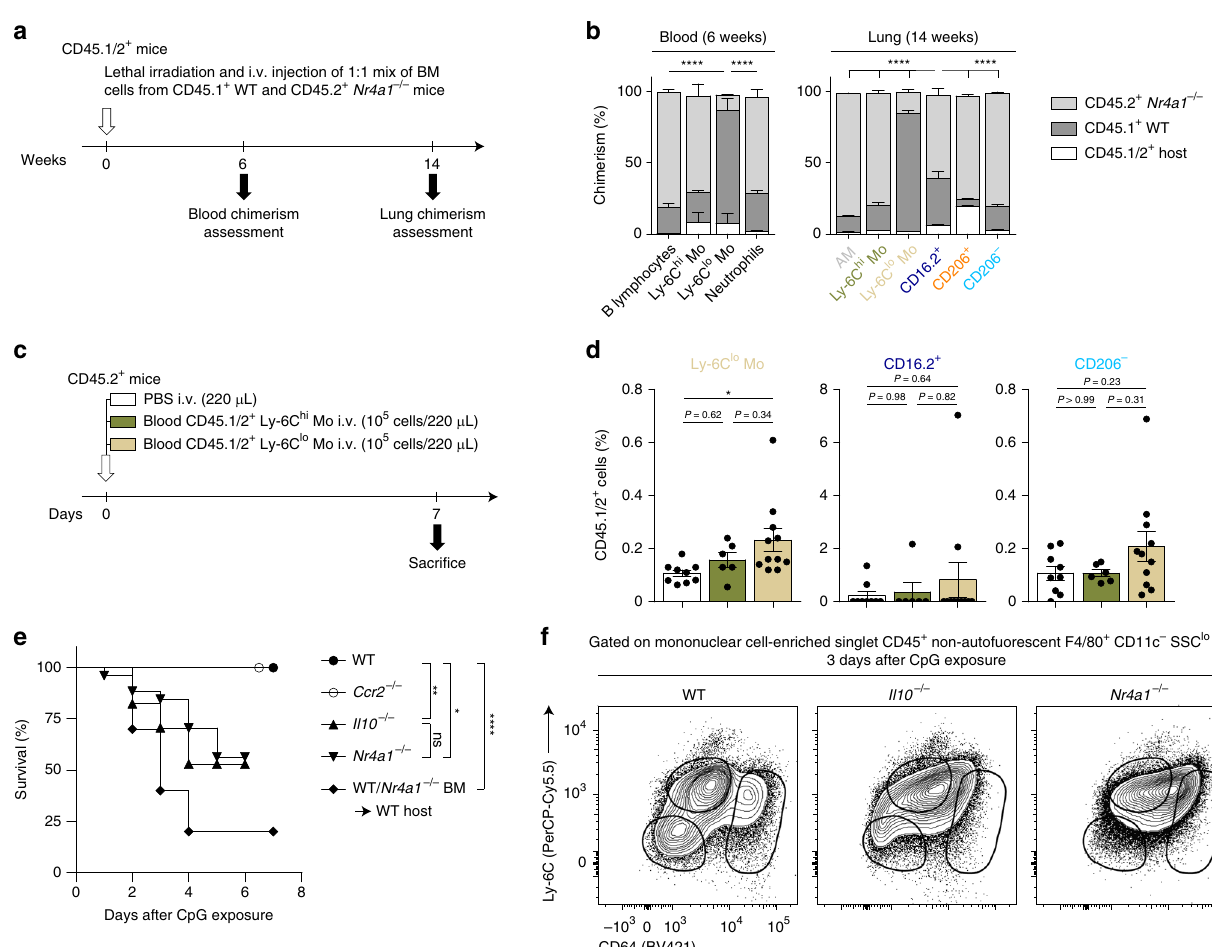
Fig. 7 Patrolling monocyte-derived NR4A1-dependent CD16.2 + monocytes are local precursors of CD206 − IM. a Experimental outline for experiments using mixed BM competitive chimeras shown in ( b ). b Percentage of BM chimerism and radio-resistance of the indicated populations. c Experimental outline for ( d ). d Percentages of CD45.1/2 + cells within the indicated cell populations. e Survival (% of live animals) were monitored at the indicated mice after CpG treatment. P- values are versus CpG-injected WT mice. f Representative contour plot of Ly-6C and CD64, gated on singlet mononuclear cell- enriched CD45 + non-auto fl uorescent SSC lo F4/80 + CD11c − cells (see Fig. 1a). Data are representative of 1 of 4 mice analyzed, each giving similar patterns. Data in b , d shown mean ± s.e.m., as well as individual mice in ( d ), and are pooled from ( b ) 2 or ( d ) 3 independent experiments ( b , n = 3 [blood] or